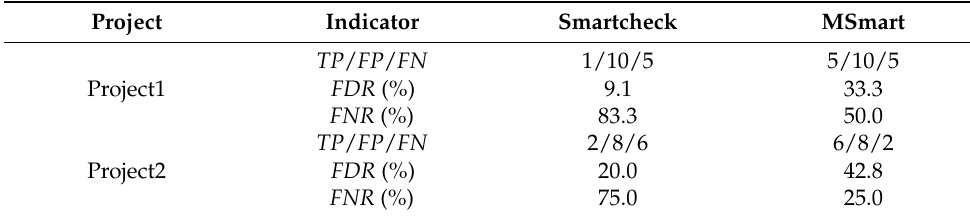
Table 4. Comparison of MSmart and Smartcheck on specific projects.